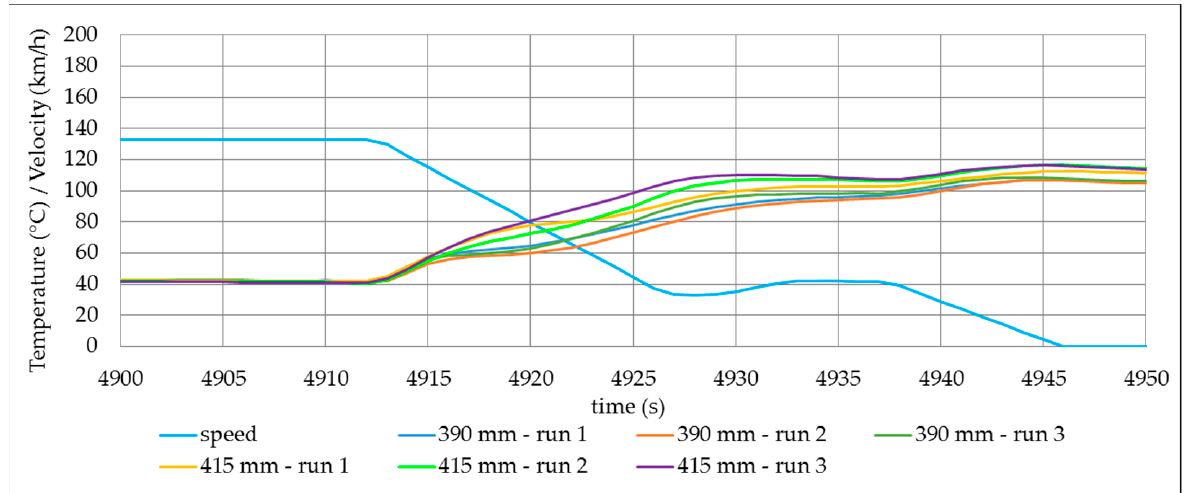
Figure 14. Temperature profile of the conventional grey cast iron (GCI) discs along brake event 106 of trip #10 of the WLTP brake cycle (Vehicles 1 and 2).